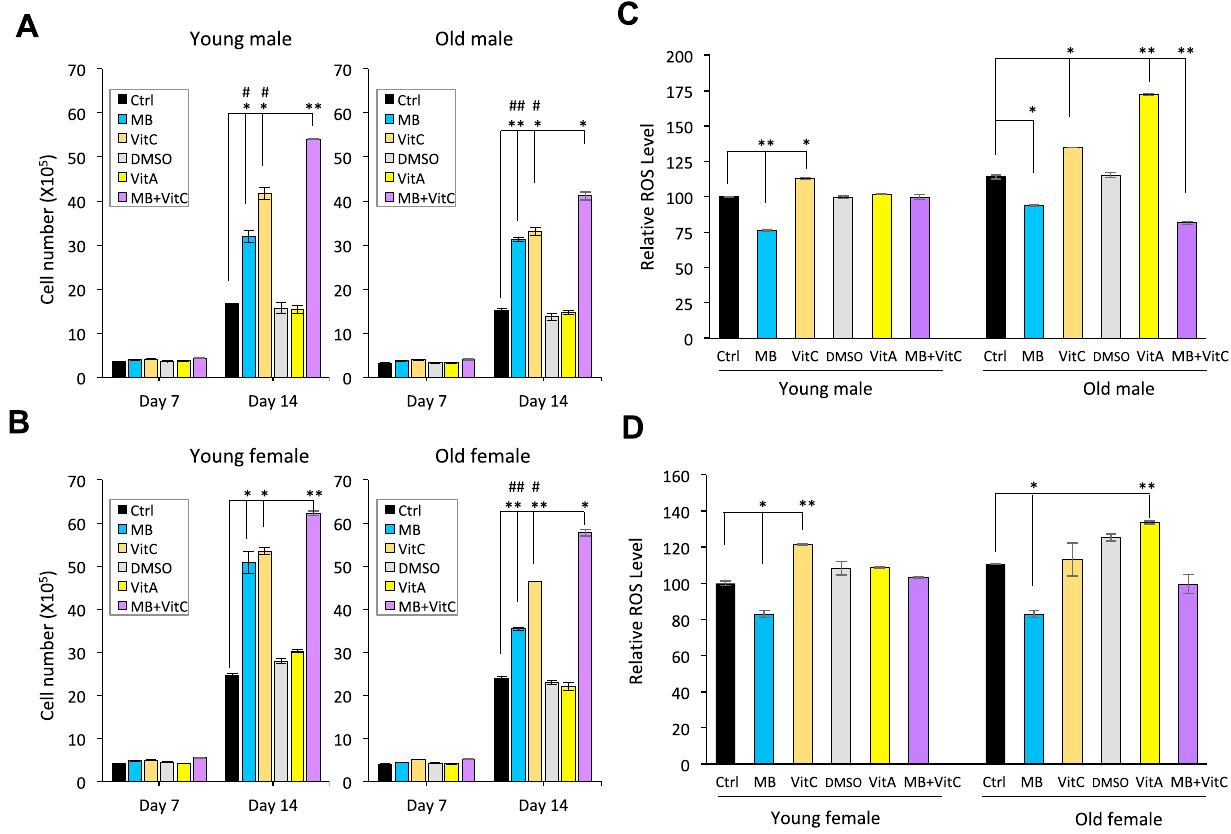
Figure 4. MB is a more effective ROS scavenger than Vitamin A and Vitamin C in human skin fibroblasts. ( A ) Young (Left) and old (Right) male fibroblasts proliferation during the fourteen-day treatment with control PBS, 0.01% DMSO, 100 nM MB, 100 nM Vitamin A, 100 μM Vitamin C, and 100 nM MB + 100 μM Vitamin C, respectively. p < 0.05, ** p < 0.01 comparing with Control PBS on the same day; # p < 0.05 or ## p < 0.01 comparing with MB + Vitamin C-treated cells on the same day. ( B ) Young (Left) and old (Right) female fibroblasts proliferation during the fourteen-day treatment with control PBS, 0.01% DMSO, 100 nM MB, 100 nM Vitamin A, 100 μM Vitamin C, and 100 nM MB + 100 μM Vitamin C, respectively. p < 0.05, ** p < 0.01 comparing with Control PBS on the same day; # p < 0.05 or ## p < 0.01 comparing with MB + Vitamin C-treated cells on the same day. ( C ) Comparison of the mitochondrial specific superoxide (MitoSOX) levels in young and old male fibroblasts after the treatment of control PBS, 0.01% DMSO, 100 nM MB, 100 nM Vitamin A,